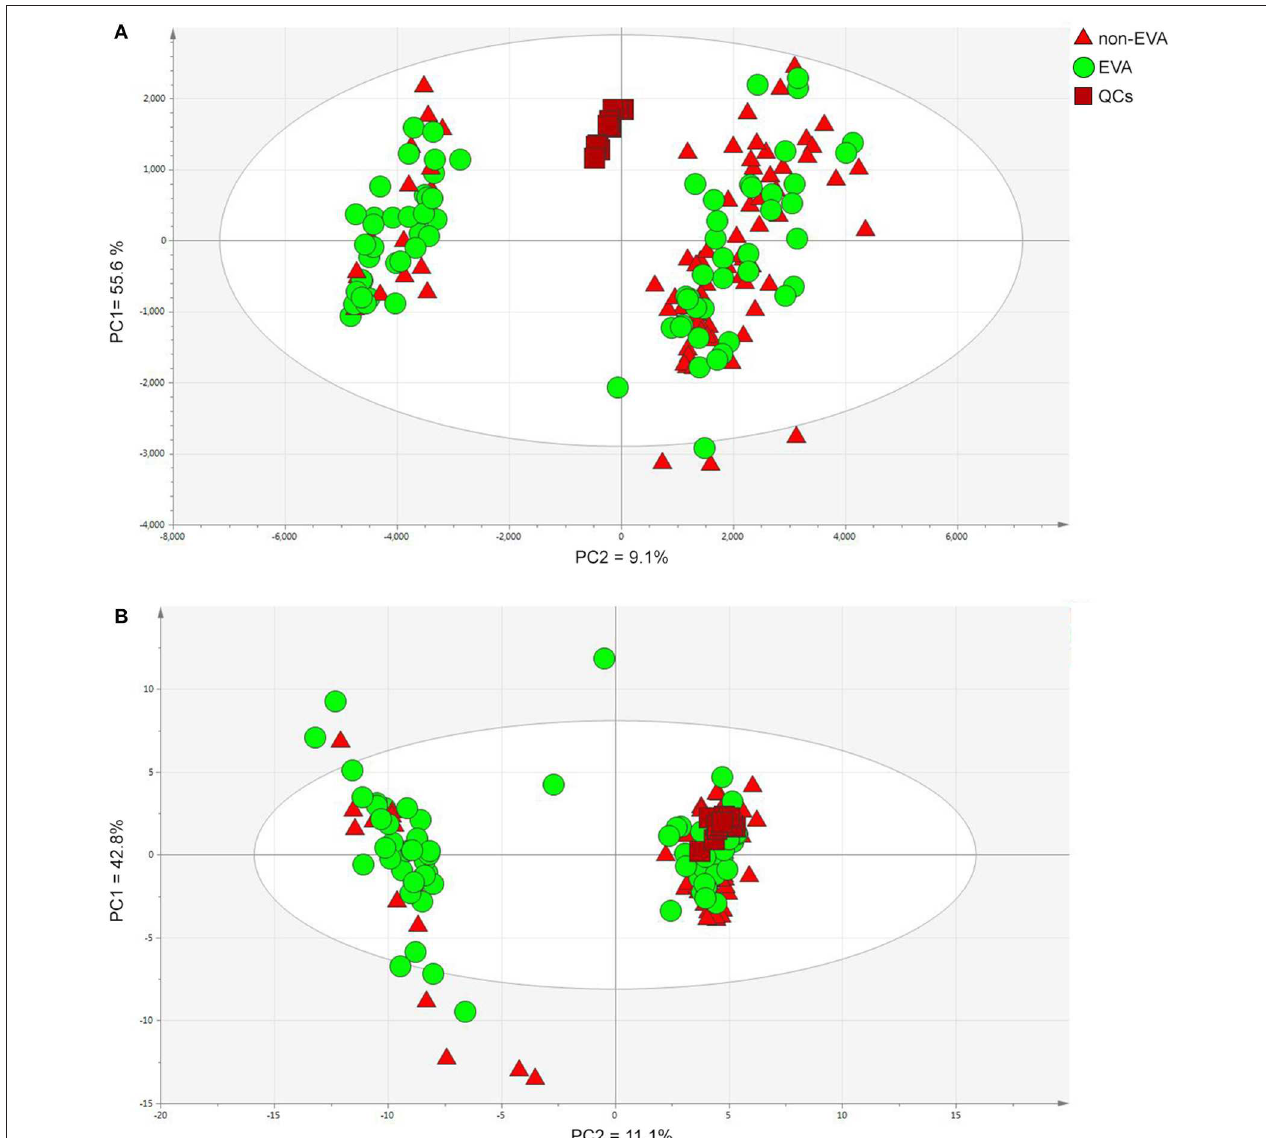
FIGURE 1 | PCA models for dataset after filtration obtained in positive (A) and negative (B) ion modes. PC1/2—principal component 1/2. Data were log transformed and Pareto or UV scaled in the case of positive and negative ionization modes, respectively. (A) PCs contribution (PC1 = 55.6 % and PC2 = 9.1%), (B) PCs contribution (PC1 = 42.8%, PC2 =